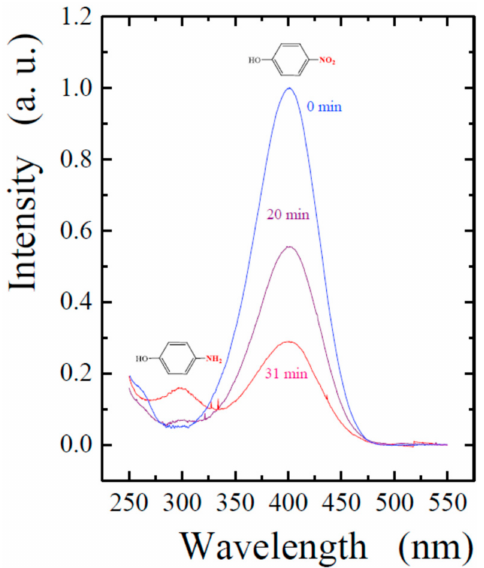
Figure 8. UV-vis spectra of the reaction mixture before the start of the process (0 min, spectrum of 4-nitrophenol) and after a number of time intervals (shown next to the curves) after the start of the catalytic reduction reaction. The initial concentration of 4-nitrophenol was 0.5 mM, NaBH 4 , 10 mM. The bionanocomposite was prepared by dipping TA@SiO 2 containing 0.1 wt.% TA into a solution with 0.2 mM AgNO 3